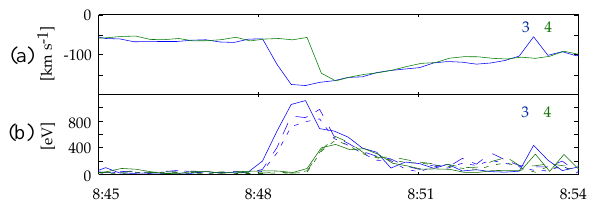
Fig. 7. Detailed plot of data from a mesoscale heating event. Panel (a) shows the field-aligned velocity for O + for spacecraft 3 and 4. Panel (b) shows the parallel and perpendicular temperatures mea- sured by the same satellites (solid line is parallel